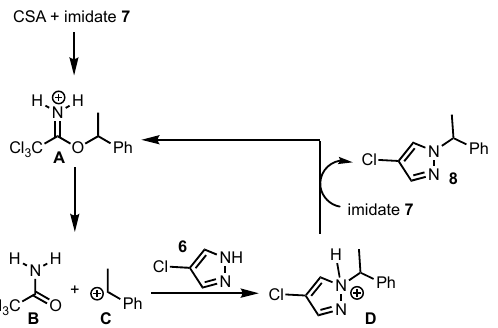
Figure 2. Proposed Reaction